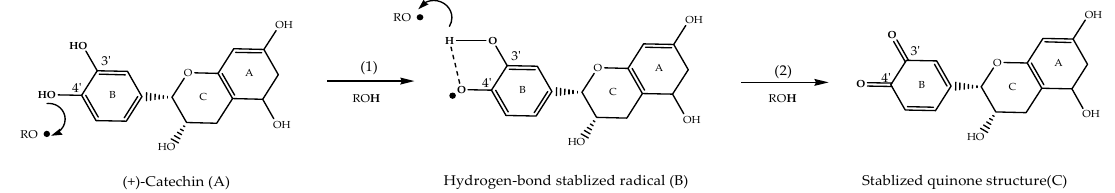
Figure 6. Schematic diagram of hydrogen transfer mechanism in (+)-catechin. (A): (+)-Catechin; (B): Hydrogen bond stabilized radical; (C): Stabilized quinone structure.